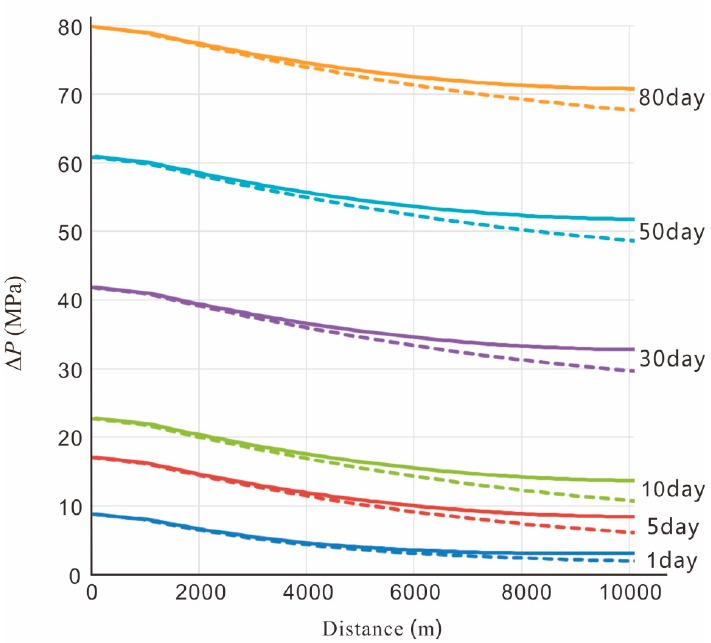
Figure 5. The increases of pore pressure along the dip (solid line) and strike (dashed line) from the intrusion point in the fault plane.